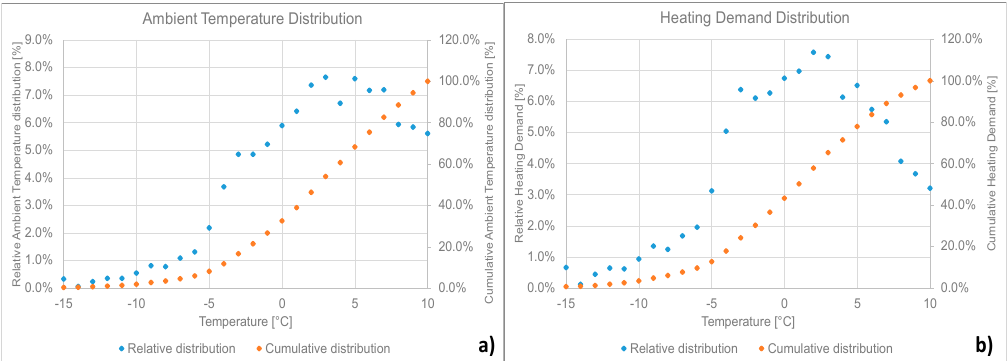
Figure 6. Ambient temperature distribution for the heating season in Stockholm ( a ) and heating demand derived from the climatic analysis ( b ).